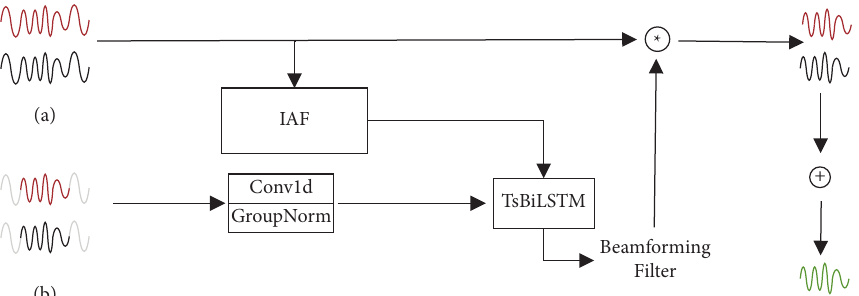
Figure 1: The overall process of multichannel speech enhancement model based on IAF. (a) The speech signal with context. (b) The original speech signal. “IAF” and “TsBiLSTM” denote the feature extraction and feature filter using the TsBiLSTM model, respectively.